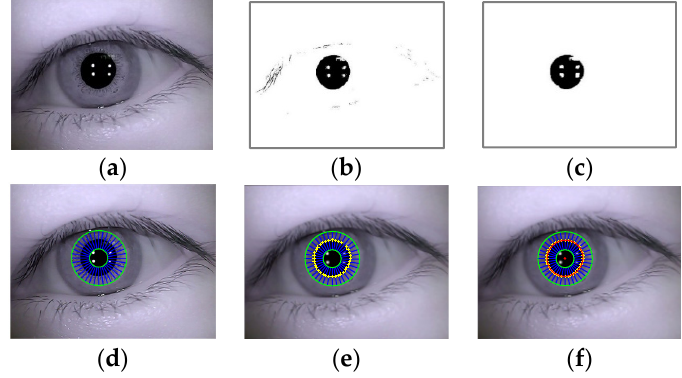
Figure 5. Pupil detection: ( a ) original eye image; ( b ) eye binary image utilizing improved Otsu optimal threshold; ( c ) results of opening ‐ and ‐ closing operation; ( d ) rough location of pupil region; ( e ) extraction of pupil boundary points; ( f ) pupil contour fitting.